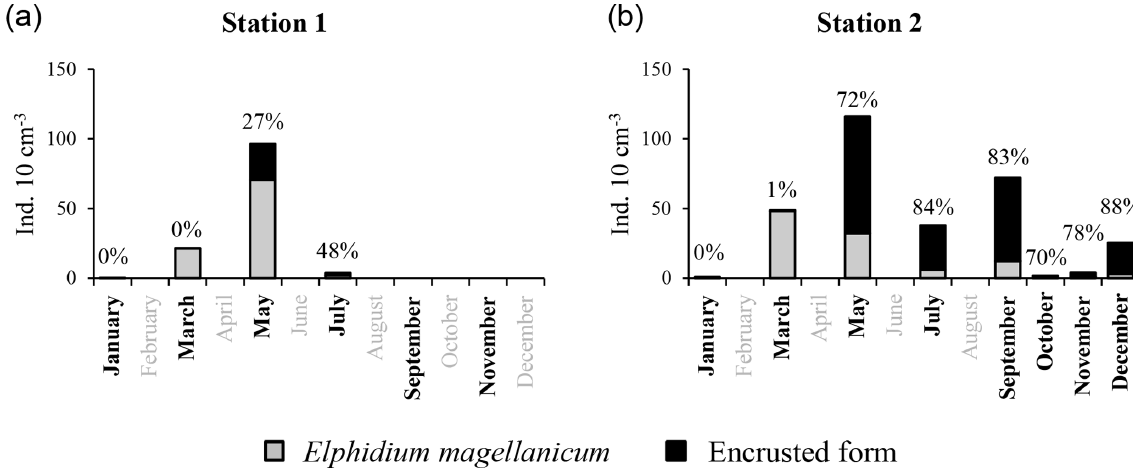
Figure 7. Mean abundances (ind. 10cm − 3 ) of non-encrusted (grey) and encrusted forms (black) of Elphidium magellanicum in 2012, at stations 1 (a) and 2 (b) , with proportion of encrusted forms above each bar (%). Investigated months are indicated in